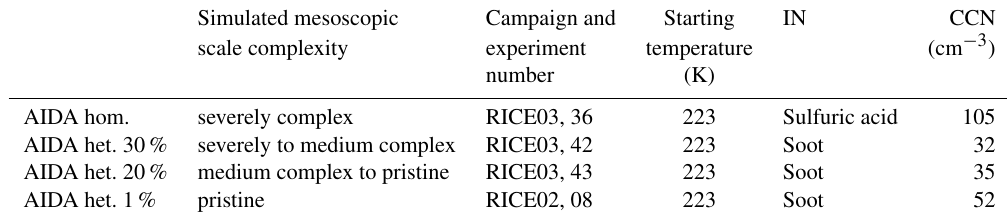
Table 1. Summary of the AIDA experiments shown in Fig. 3. The second column gives the simulated degree of complexity, the third column the AIDA campaign name and AIDA experiment number. The fourth, fifth and sixth columns give the experiment start conditions: the start temperature, the used ice nuclei (IN) and the number concentration of the aerosol acting as cloud condensation nuclei (CCN). Simulated